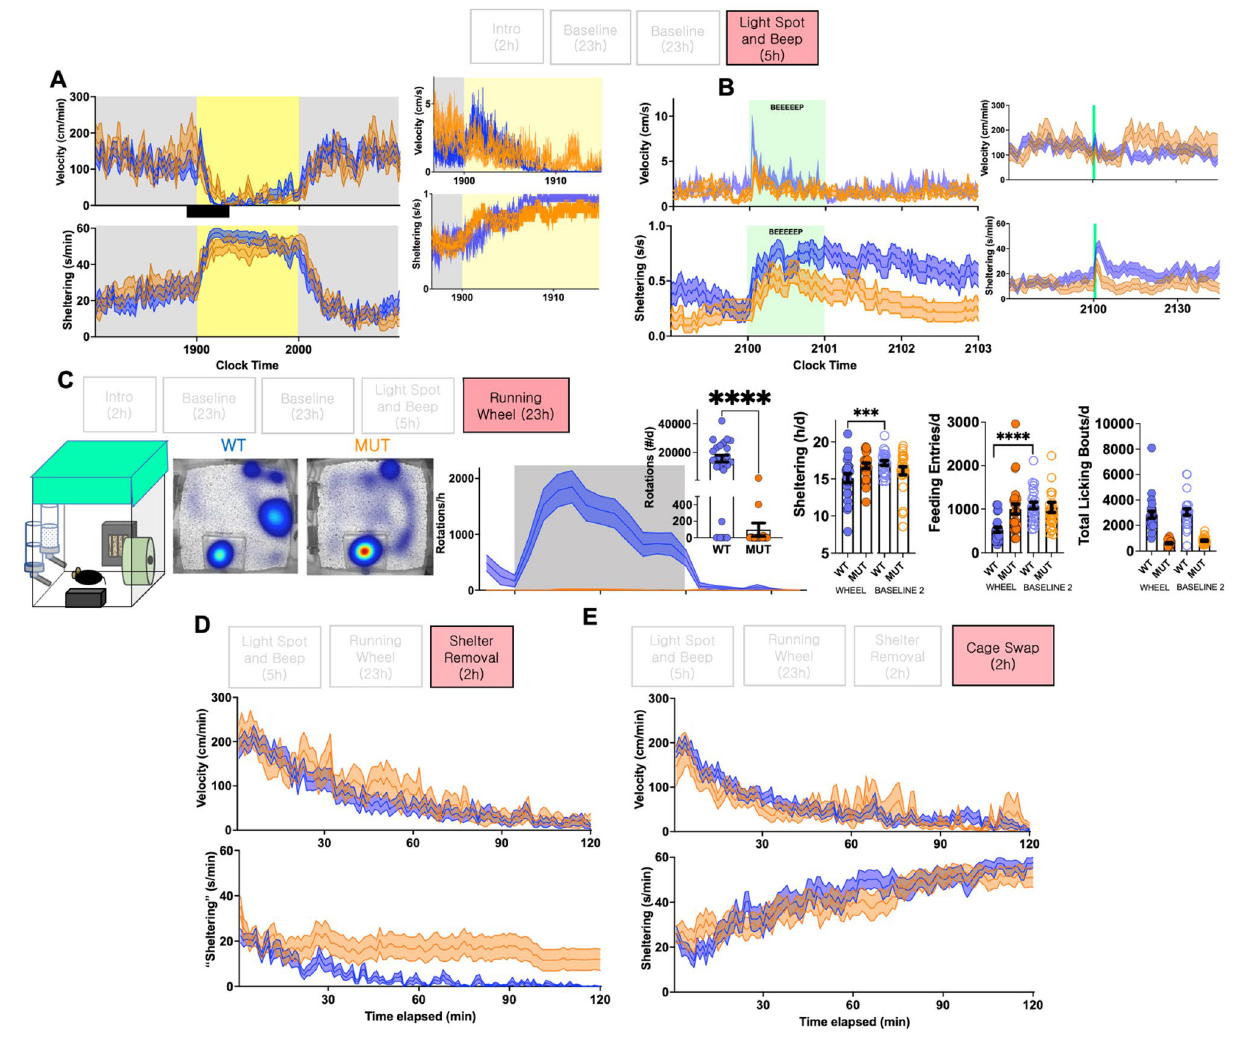
Figure 3. Provocative maneuvers. ( A ) Responses of WT and mutants to the “light spot test”. ( B ) Mutants display an attenuated early locomotor startle and sheltering response to a 60 s long home-cage beep stimulus. ( C ) Mutants display a significant reduction in wheel-running behavior. During this trial, WT mice display a relative suppression of sheltering and feeding behavior (compared with data from baseline day 2, two-tailed paired Student’s t tests). ( D ) Locomotor and sheltering response to shelter removal, and ( E ) cage swap protocol. Mean ± s.e.m water over water, mutants displayed a significantly lowered sucrose preference (Fig. 2H). Across these various phenotypes, no significant gender-based distinctions were identified (Supplementary Fig. 1). Collectively, these baseline data highlight a set of diffuse alterations in the spatiotemporal structure of spontaneous behavior in mutant mice. We began our provocative maneuvers with an hour-long “light spot test” 19,20,34 , which poses a conflict between nocturnal foraging and light aversion within their home-cage and without human presence. WT mice responded acutely with sharply increased activity followed by sustained immobility within shelters. In comparison, a rela- tively blunted locomotor suppression response was seen in mutants, with some minimal persistent exploration of the open illuminated cage (Fig. 3A). Similarly, in response to a 60 s-long pure tone, mutants exhibited an attenuated startle and sheltering response compared with WT mice (Fig. 3B). On the following day, when pro- vided access with a running wheel, wheel-running behavior was almost entirely absent in mutants, with only 3/26 mutants successfully engaging the wheel. Compared with baseline recordings, wheel access suppressed feeding and sheltering in WT mice, an effect that was absent in mutants (Fig. 3C). Finally, we applied two additional brief daytime perturbations. Since mice spend the bulk of their light period/ daytime within shelters 19,20 , we examined their response to transient shelter removal. While WT mice settled in cage corners, many mutants rested in the cage location previously occupied by the shelter (Fig. 3D). In a second daytime maneuver, mice were manually repositioned into a cage previously inhabited by a gender-matched mouse ("cage swap"), providing a geometrically similar field with novel olfactory cues. Unlike their initial habitu- ation response (Fig. 1A), activity patterns and gradual shelter entry were similar (Fig. 3E).